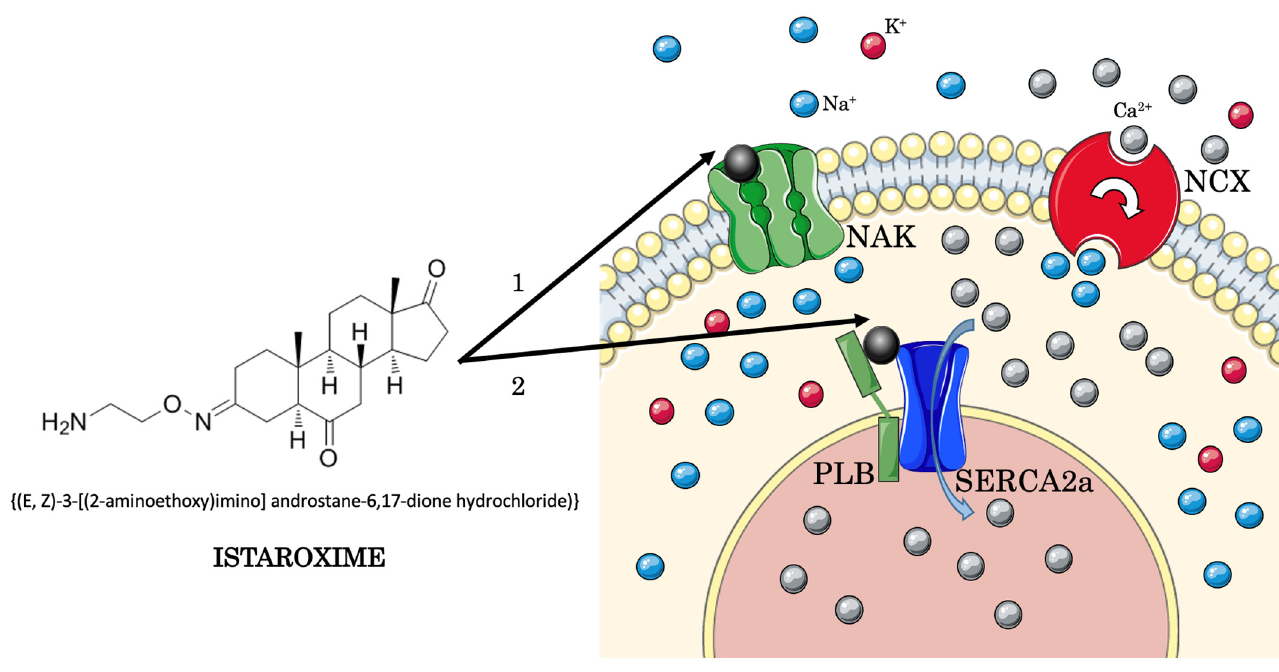
Figure 3. Dual mechanism of action of istaroxime. Istaroxime (structure depicted on the left) inhibits NAK by binding it from the extracellular side. NAK inhibitions increase [Na + ] inside the cytoplasm, activating NCX that expels three Na + -ions in one Ca 2+ ion exchange, raising [Ca 2+ ] inside the cytoplasm, increasing myocardial contractility (inotropic effect); istaroxime activates SERCA with a direct interaction with the complex formed by SERCA2a and PLB, independent of PLB phosphorylation. SERCA2a stimulation triggers an influx of Ca 2+ against the gradient from the cytosol to the SR, guaranteeing the relaxation of cardiac muscle fibers (lusitropic effect) and a sufficient amount of Ca 2+ storage in the SR that can be utilized to start a new contractile activity for the ensuing contraction (empowerment of inotropic effect). NAK: Na + /K + -ATPase pump; NCX: Na + /Ca 2+ exchanger; PKA: protein kinase A; PLB: phospholamban; SERCA: sarco/endoplasmic reticulum Ca 2+ ATPase.